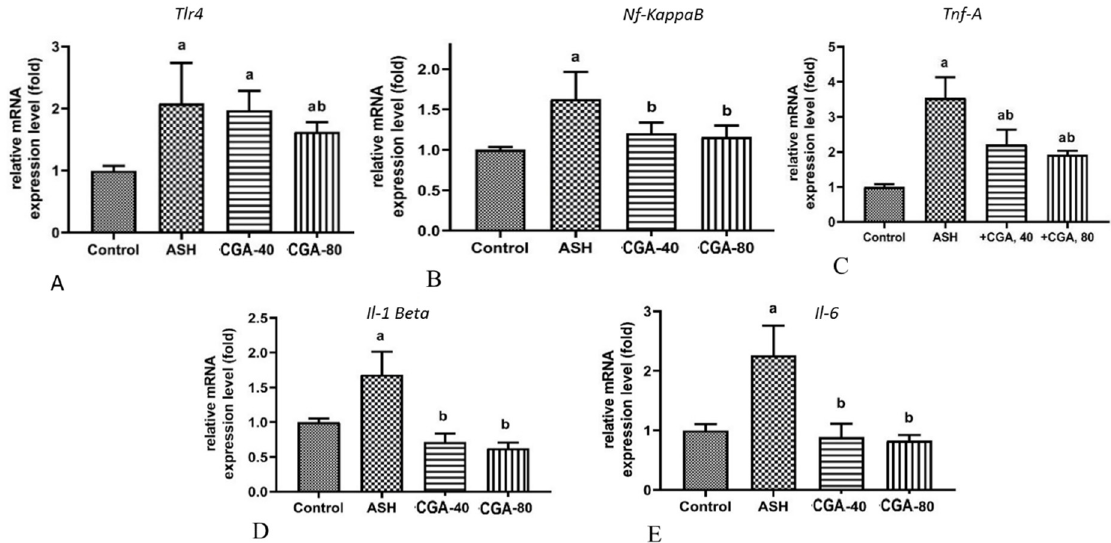
Figure 4. Effect of two CGA doses (40 and 80 mg/kg) on the expression of inflammation-related genes in the liver of rats with alcoholic steatohepatitis (ASH) induced by chronic alcohol intoxication. ( A )—Tlr4; ( B )—Nf-kB; ( C )—Tnf α ; ( D )—Il-1 β ; ( E )—Il-6. M ± SD. a— p < 0.05 compared to the control group; b— p < 0.05 compared to the ethanol-administered group.